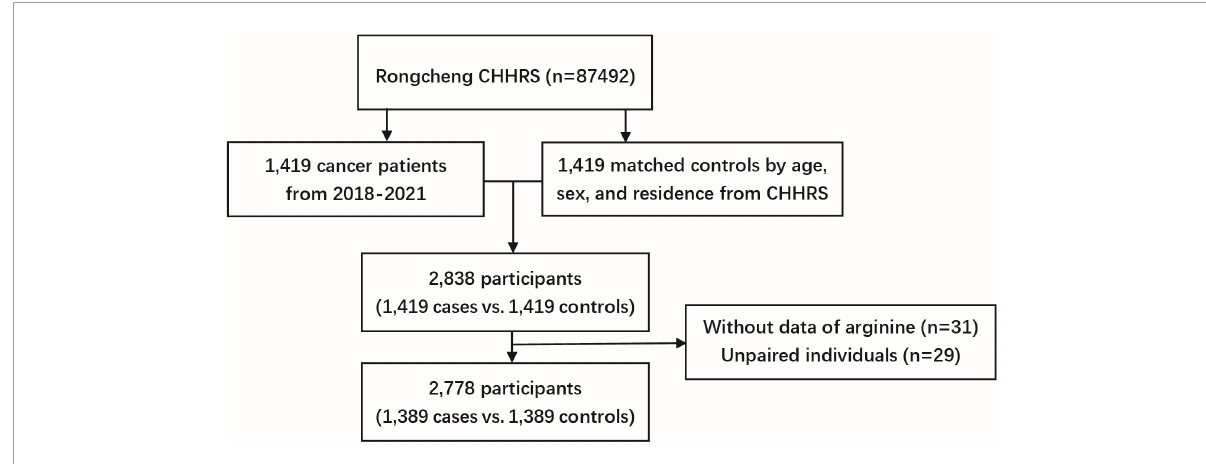
FIGURE1 Flow chart of study participants in the nested case-control study within the HHPCP.